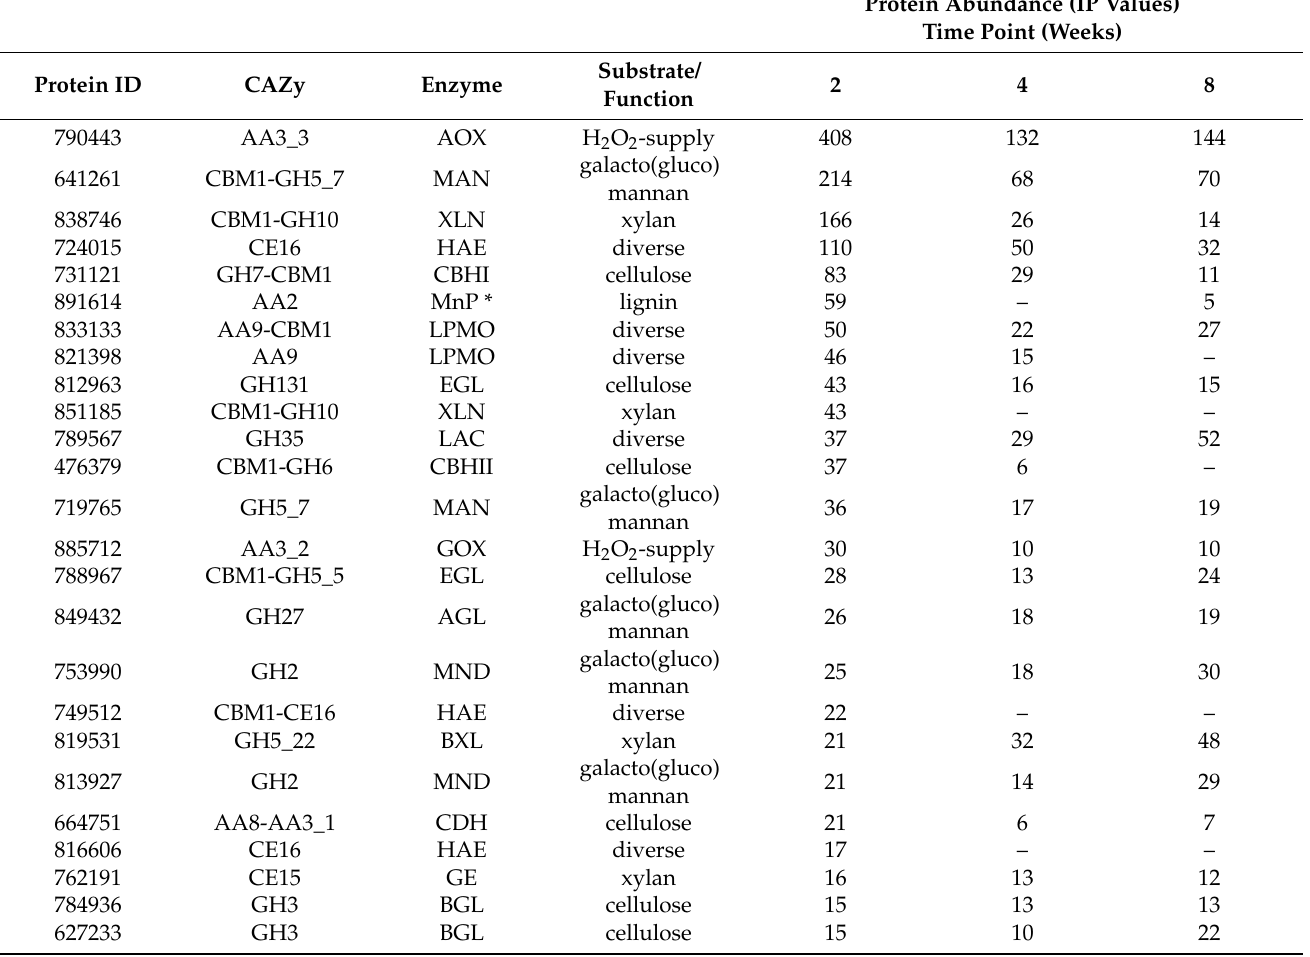
Table 2. The 25 most abundant plant cell wall degrading CAZymes produced by O. rivulosa during growth on solid spruce wood. IP values = ion profile values. Protein IDs assigned by JGI Myco- Cosm (https://mycocosm.jgi.doe.gov/Obbri1/Obbri1.home.html, accessed 5 April 2022). Enzyme abbreviations are presented in Supplementary Table